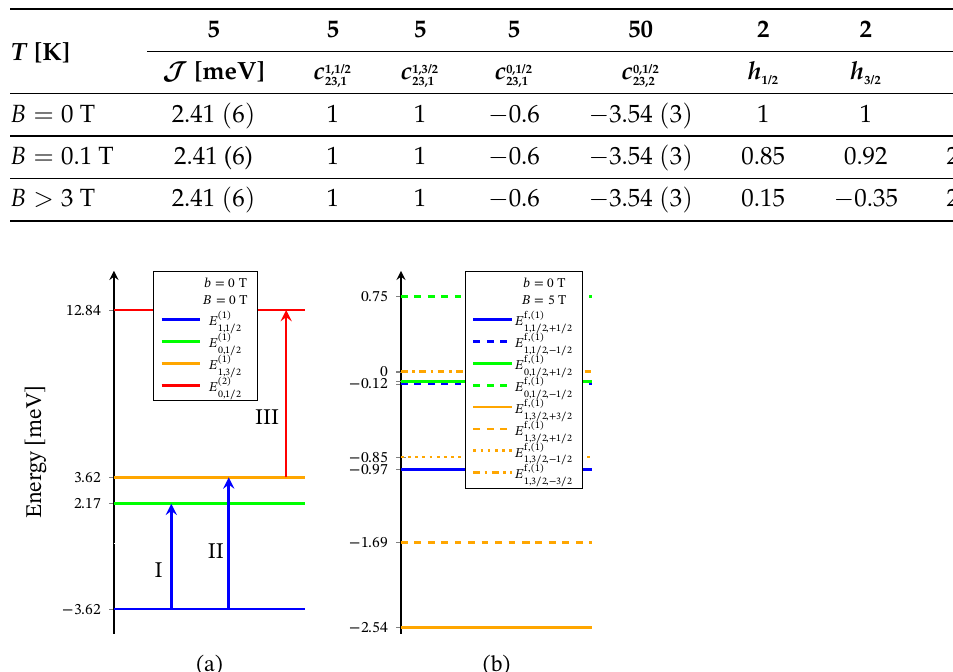
Table 1. The values of all parameters entering in (2) for Na 9 [Er(W 5 O 18 ) 2 ]. The first row shows the temperature corresponding to the measurements. The evaluation of J and the spectroscopic parameters ‘ c ’ is made in accordance to the neutron spectroscopy data shown in Figures 3 and 4. The ‘ h ’ parameters are fitted in with respect to the magnetization measurements depicted in Figure 5. All experimental data are taken from Reference [9].